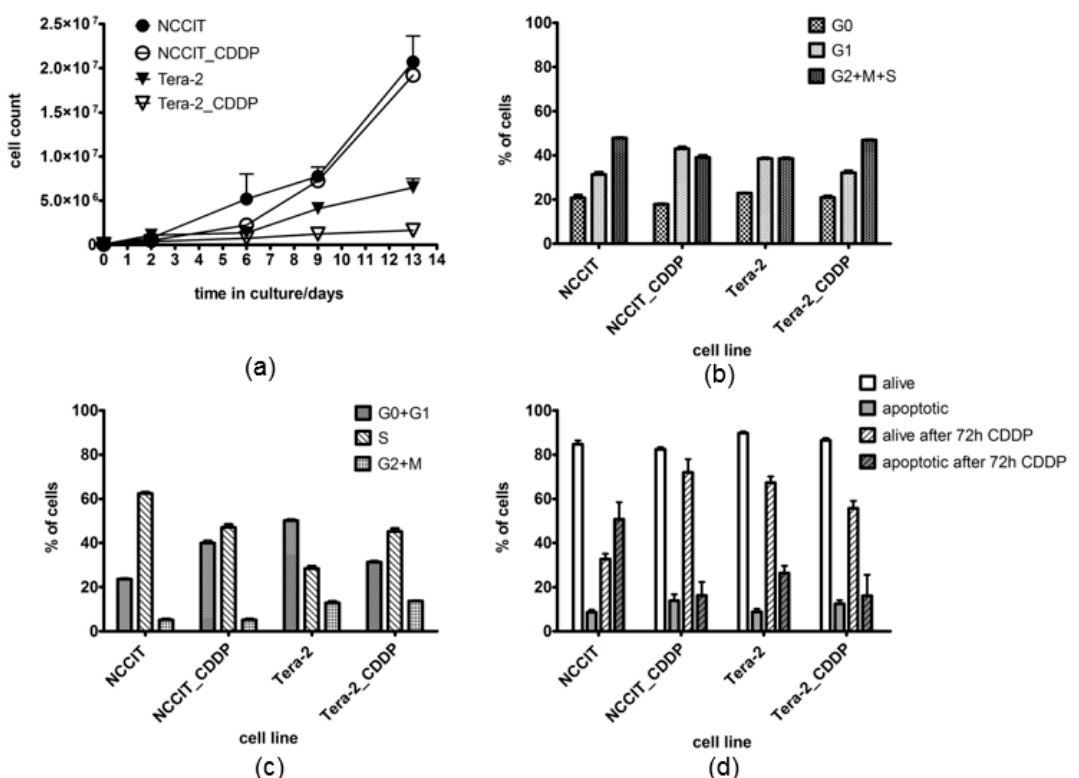
Figure 2. Proliferation and cell cycle of TGCTs cell lines. ( a ) proliferation of the cells expressed in total numbers of cells during two week cultivation; ( b ) pyronin/hoechst cell cycle analysis; ( c ) EdU cell cycle analysis; ( d ) apoptosis analysis without CDDP treatment and after 72 h of CDDP treatment.